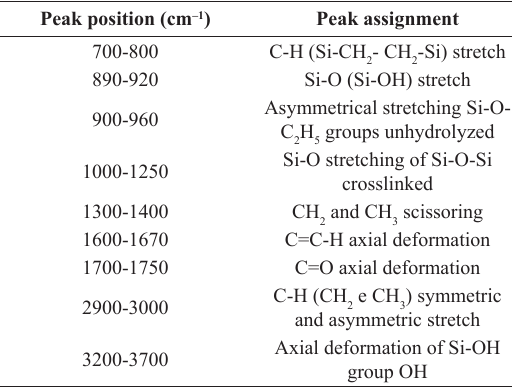
Table 2. FT-IR, peaks assignment as function of peak position. Peak position (cm –1 )